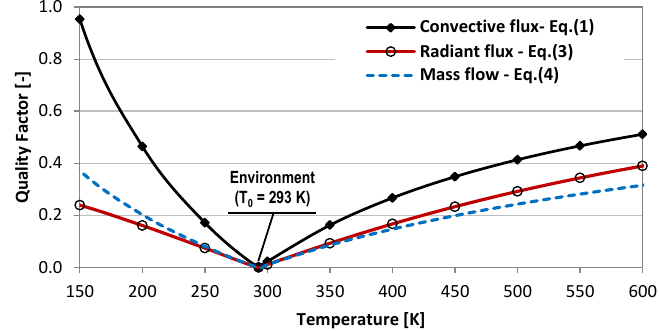
Figure 1. Exergy related to a unit thermal power as a function of temperature.